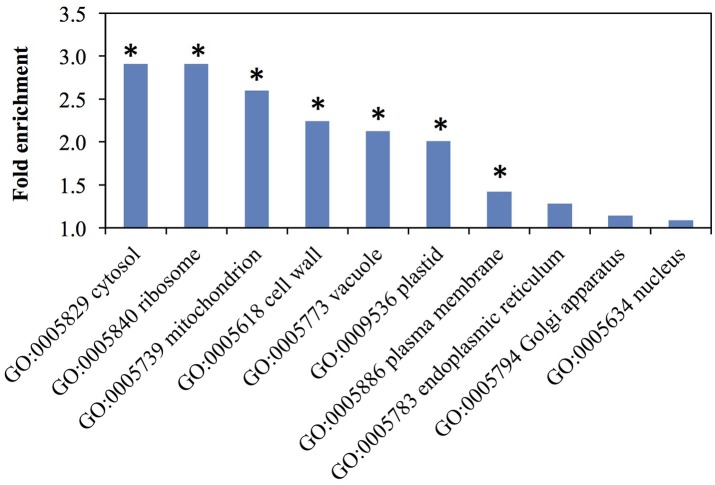
Representation of cellular component Gene Ontology (GO) terms among rice elongating internode proteins. Asterisks indicate over-representation with a p-value <0.01 by hypergeometric test. Fold enrichment is the ratio of identified proteins to the expected number of proteins for each GO term.